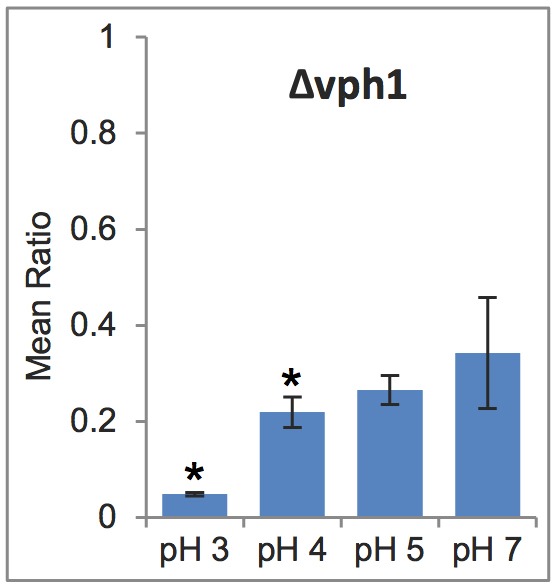
The vacuolar ATPase subunit Vph1 is an acid stress resistance gene. The mean ratio of growth of the Δvph1 pma1-007 double mutant relative to the Δvph1 single mutant is plotted for screens performed at the indicated pH values (n=3). Note that at pH 3 the double mutant is extremely slow growing and at pH 7 it is not rescued fully to the growth of the Δvph1 single mutant (i.e. mean ratio<1). This is likely because loss of vacuolar ATPase function also results in intracellular acid stress (Young et al., 2010). Error bars indicate s.e.m. *P<0.05 vs pH 7 by Student's t-test.